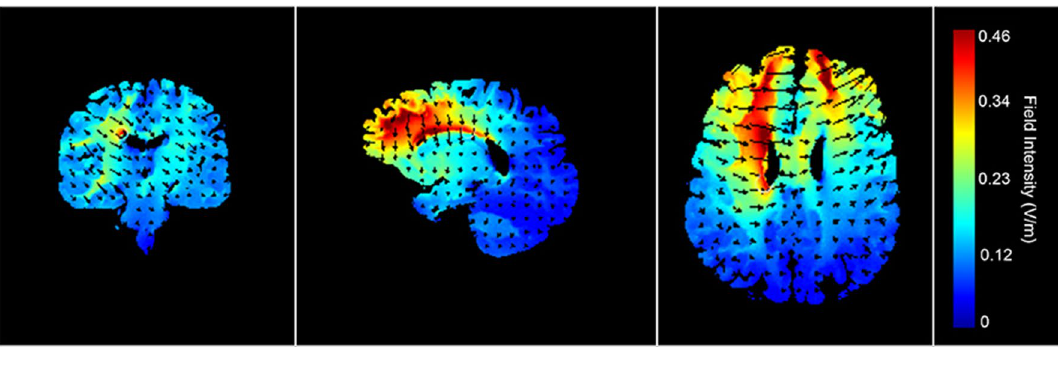
Figure 2. Electric field simulations of the tDCS